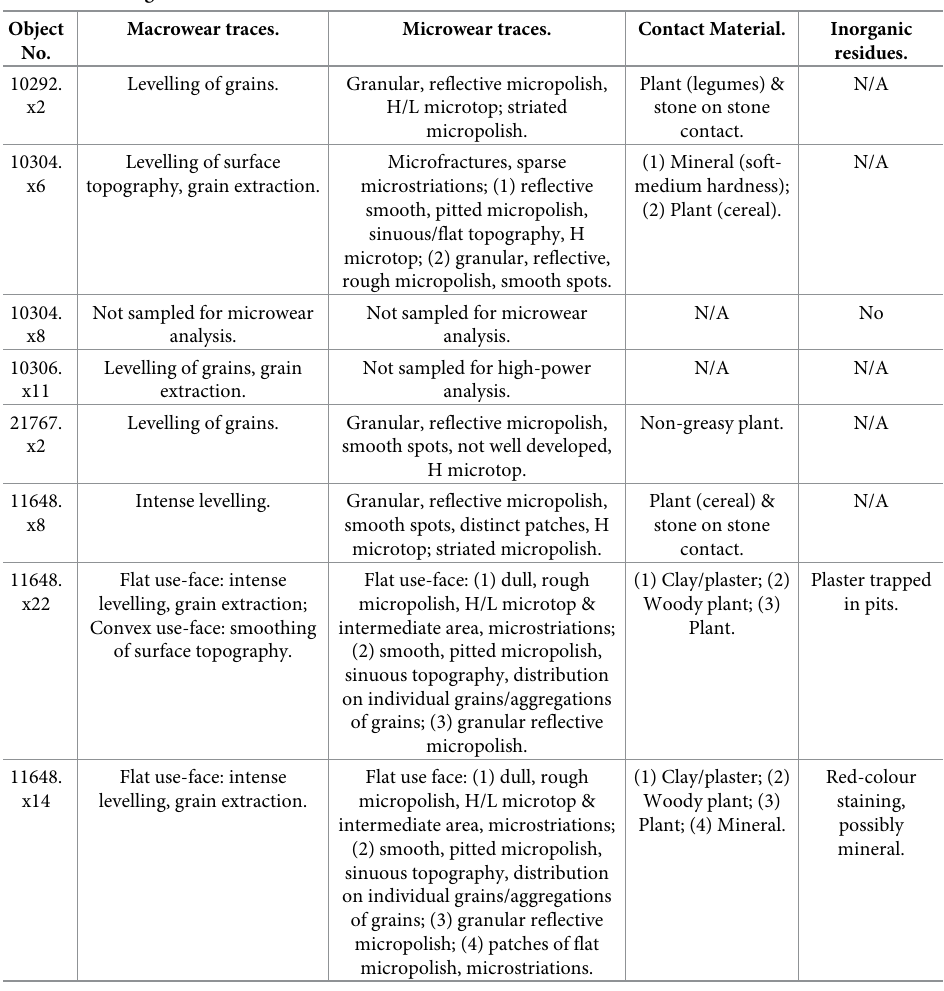
Table 6. Grinding tools’ microwear